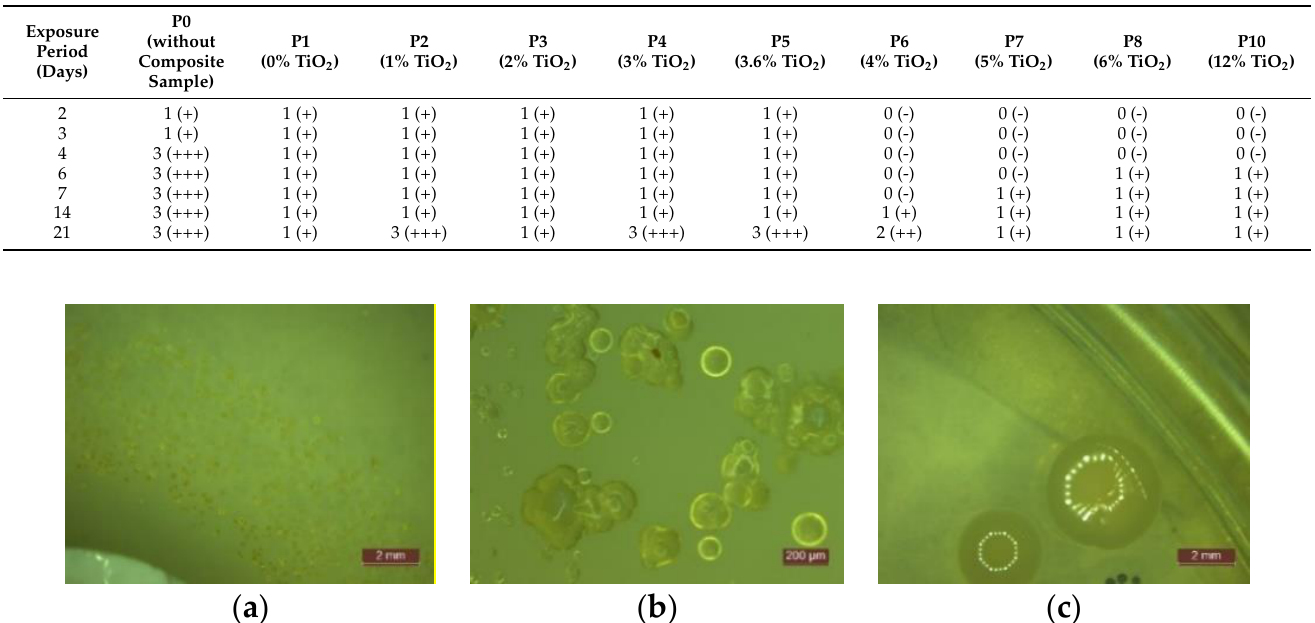
Figure 2. Microscopic examination of the behavior of samples exposed to Escherichia Coli : ( a ) Iden- tification of the inhibition halo area (1:2 mm); ( b ) Growth colonies (1:200 µ m); ( c ) Detail of growth colonies (1:2 mm).